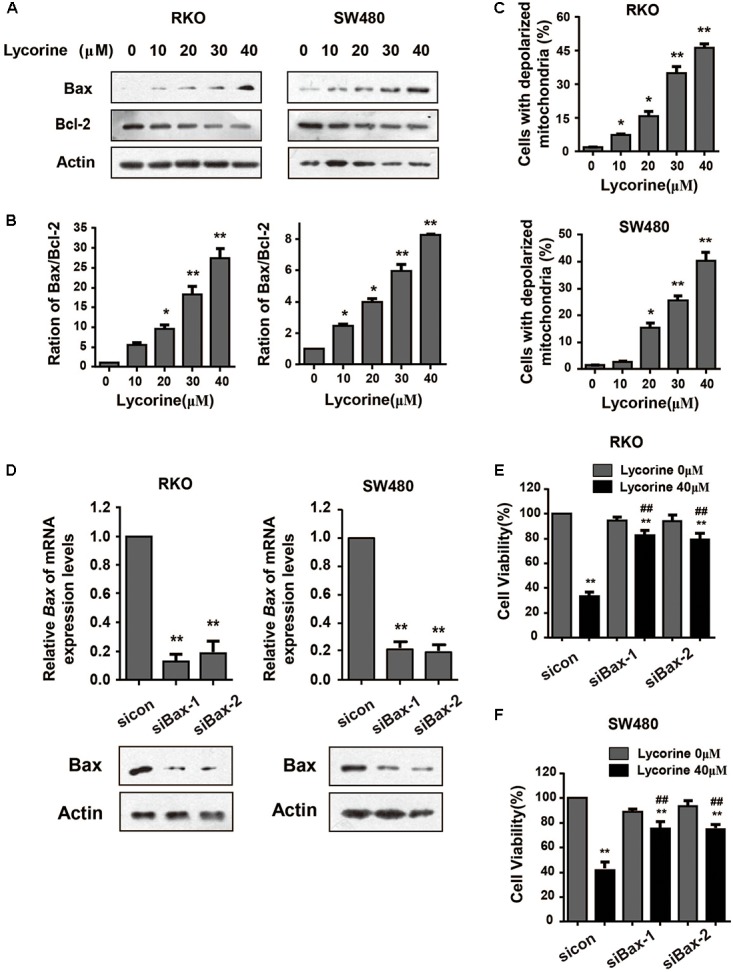
Lycorine promotes CRC apoptosis via the mitochondrial pathway. (A) Western blotting analysis shows that the protein expression of Bcl-2 and Bax was measured in RKO and SW480 cells treated with indicated concentrations of lycorine for 48 h. (B) Density ratios of Bax/Bcl-2 protein expression level were shown in the histogram. (C) The membrane depolarization of mitochondria was detected by flow cytometer. (D) Bax in RKO and SW480 cells was transiently transfected with two individual Bax siRNA (si.Bax-1 and si.Bax-2) or control siRNA (si.Control) for 48 h and was determined by Real-time PCR and Western blot assays. (E) Cell viability was determined in lycorine-inhibited and Bax-knocked down RKO and SW480 cells for 48 h. For (B–D), data are shown as mean ± SD (n = 3); ∗P < 0.05; ∗∗P < 0.01 compared with control (Student’s t-test). For (E,F), data are shown as mean ± SD (n = 3); ∗∗P < 0.01 compared with control; ##P < 0.01 compared with si.control transfected cells treated with lycorine (Student’s t-test). All the western data shown are representative of at least three independent experiments.